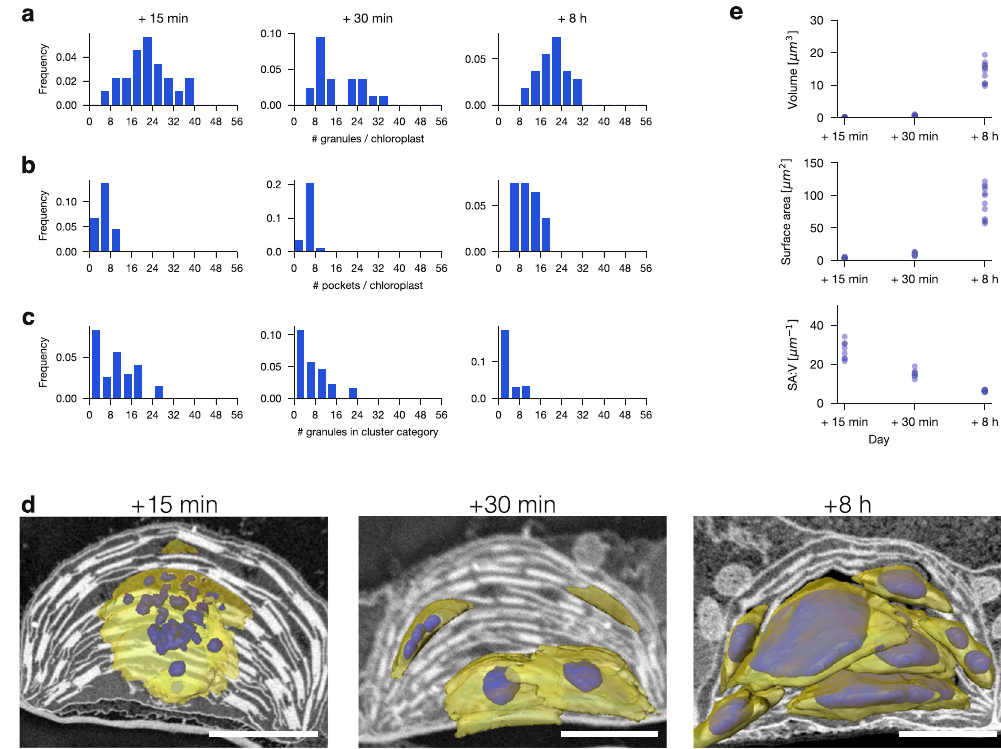
Fig. 2 Imaging of entire chloroplasts to determine the exact number of starch granules. Tomographic reconstruction from SBF-SEM image stacks of entire chloroplasts from plants sampled after a prolonged night and after 15 min, 30 min, and 8 h light. a The number of granules per chloroplast. b The number of starch-containing pockets per chloroplast. c Number of granules in each cluster category. Data in a – c are expressed as frequency distributions (bins of 4, including 0 in a and b , excluding 0 in c ), where the height of the bar represents the frequencies within each bin. For each time point, two plants from two independent experiments were examined. In total, 22, 21, and 27 chloroplasts were examined for the 15-min, 30-min, and 8-h time points, respectively. d 3D-renderings of representative chloroplasts (non-inverted SEM images) with the pockets (yellow) and their starch granules (violet). Scale bars: 2 µ m. e The volume (top), surface area (middle), and the surface area-to-volume ratio (SA:V; bottom) for the total starch in each chloroplast. In total, 8, 8, and 12 chloroplasts were examined for the 15-min, 30-min, and 8-h time points, respectively, to determine these